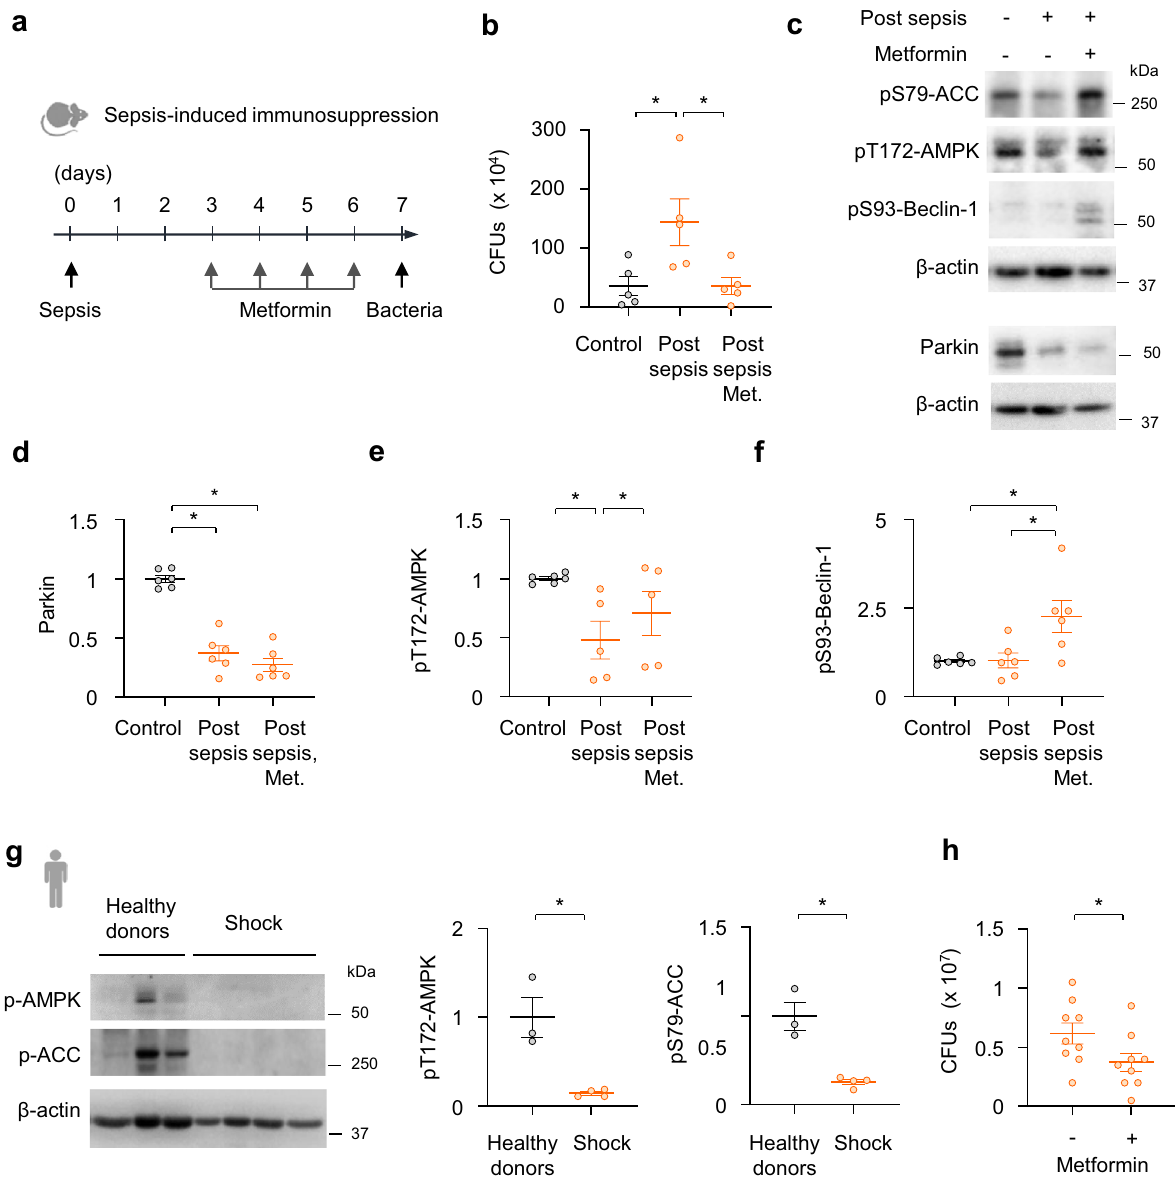
Figure 6. AMPK activator metformin activates Parkin-independent autophagy and improves bacterial killing in lungs of sepsis-immunosuppressed mice. ( a ) Outline of therapeutic dosing for metformin in sepsis- immunosuppressed mice followed by bacterial pneumonia. ( b ) CFUs from lung homogenates of indicated groups of mice. Mean ± s.e.m., n = 5 per control, post-sepsis and post-sepsis mice treated with metformin (Met.) groups. * P < 0.05, ANOVA. ( c ) Representative Western blots and quantitative analysis of ( d ) Parkin, ( e ) p-AMPK, and ( f ) pSer93-Beclin-1 from lung homogenates of control and sepsis-immunosuppressed mice. Data presented as mean ± s.e.m., n = 5–6. * P < 0.05, ANOVA . ( g ) Western blot analysis of pThr172-AMPK and pSer79-ACC and β-actin in monocytes from healthy donors and patients that survive shock (24 h after shock). Mean ± s.e.m., n = 3 (healthy donors), n = 4 (post-shock). * P < 0.05, Student’s t -test. ( h ) CFUs obtained after monocytes (shock) were incubated with or without metformin (1 mM) for 2.5 h. Mean ± s.e.m., n = 3 (patients) with three technical repetitions. * P < 0.05, Student’s t